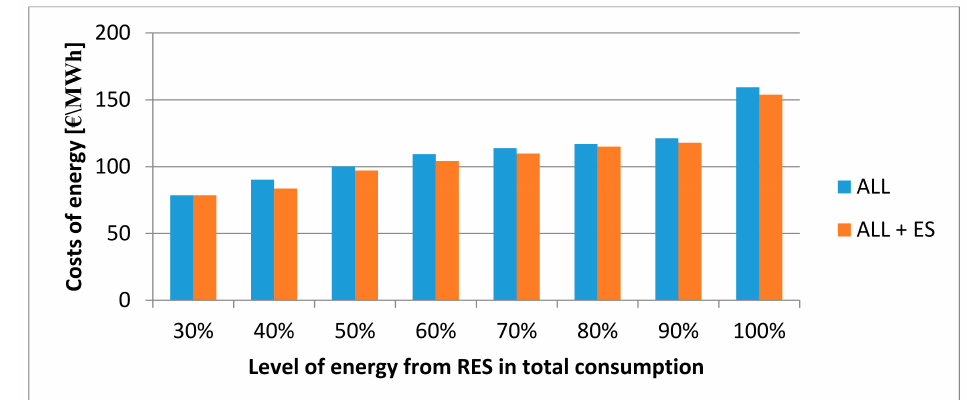
Figure 10. Energy costs for simulation